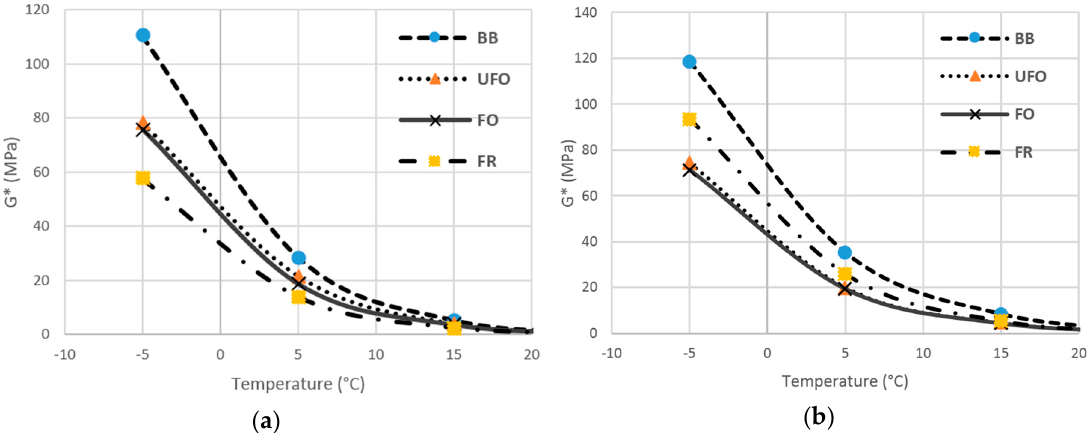
Figure 7. Effect on low temperature stiffness of asphalt binders at 10 rad/s for ( a ) unaged and ( b ) RTFO aged.